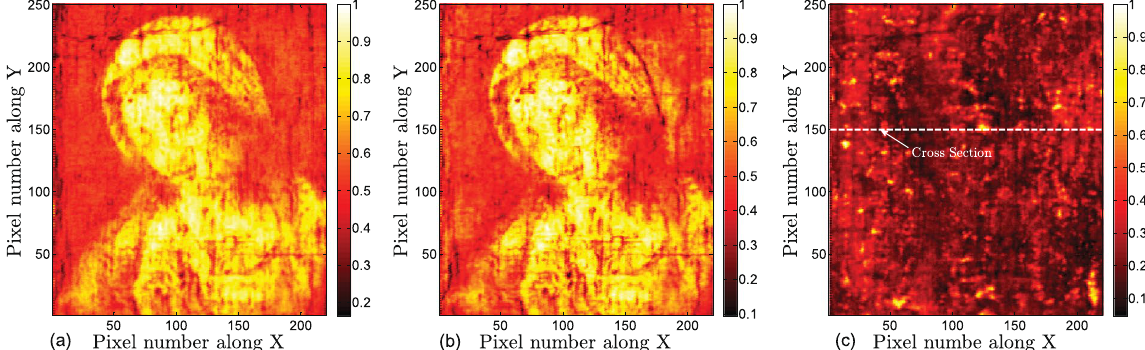
Figure 2. THz C-scans using on the raw THz data based on the following contrast mechanisms in the reflected signal: ( a ) peak-to-valley amplitude; ( b ) integrated spectrum between 0.5 and 1.0 THz; ( c ) peak-to-valley amplitude between 13 to 18 ps. The horizontal line at Y = 150, marked ‘cross section’, is in reference to the B-scan in Fig. 3. Contrast is normalized to one.